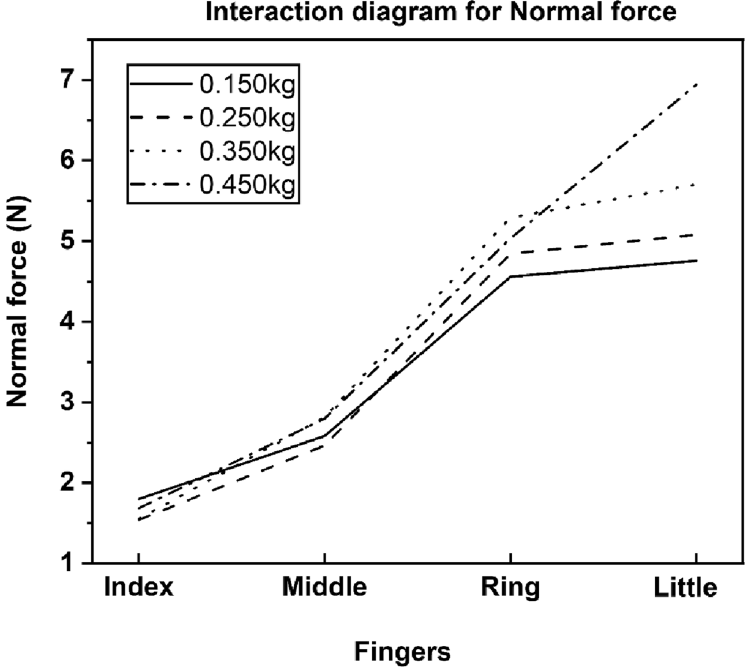
Figure 3. Interaction between loads and finger normal forces The pairwise post hoc tukey tests confirmed that the ring and little finger normal forces of 0.450 kg (Ring: 5.03 N, Little: 6.94 N) 0.350 kg (Ring: 5.29 N, Little: 5.70 N), 0.250 kg (Ring: 4.84 N; Little: 5.07 N) were statistically greater than the index and middle finger normal forces (0.150 kg: Index: 1.79 N, Middle: 2.58 N; 0.250 kg: Index: 1.54 N, Middle: 2.46 N; 0.350 kg: Index: 1.55 N, Middle: 2.81 N; 0.450 kg: Index: 1.68 N, Middle: 2.79 N) of all the loading